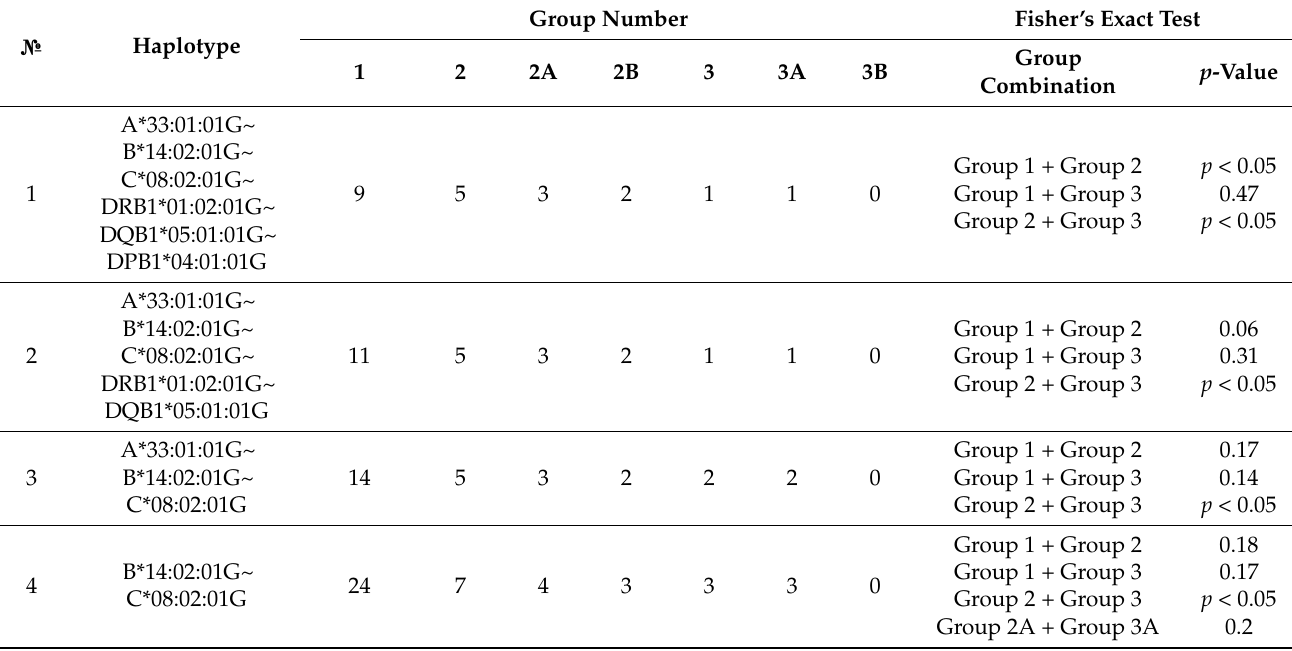
Table 8. The number of haplotypes per